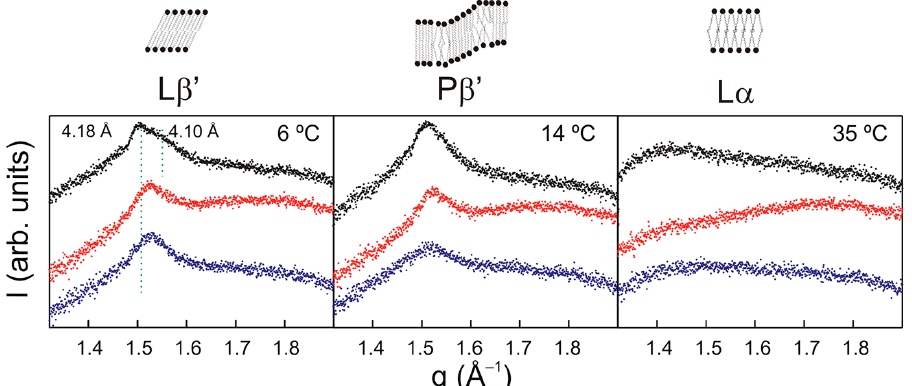
Figure 3. Intensity (arbitrary units lineal scale) vs. scattering vector ( q ) for WAXD profiles of pure DMPG (top black) and DMPG containing TMBC at 0.07 (middle red) and 0.20 mole fraction (bottom blue) at different temperatures.